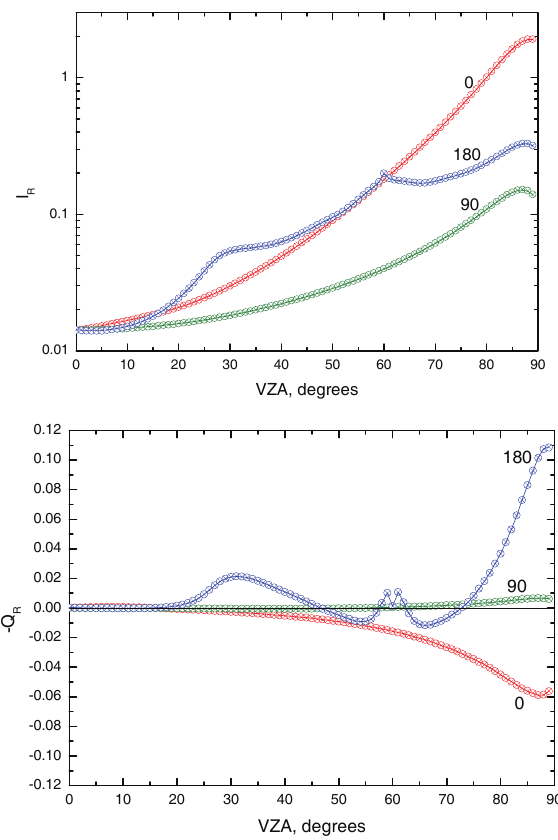
Fig. 4a. The comparison of the reflection function (upper panel) and the second Stokes parameter (lower panel) for the case of oceanic aerosol with the optical thickness 0.3262 (at 412nm) obtained using three independent radiative transfer codes. The calculations have been performed at the solar zenith angle ϑ 0 = 60 ◦ and the relative azimuths ϕ = 0 ◦ , 90 ◦ , 180 ◦ as the function of the viewing zenith an- gle (SCIATRAN – line, circles – Pstar , crosses – MYSTIC).